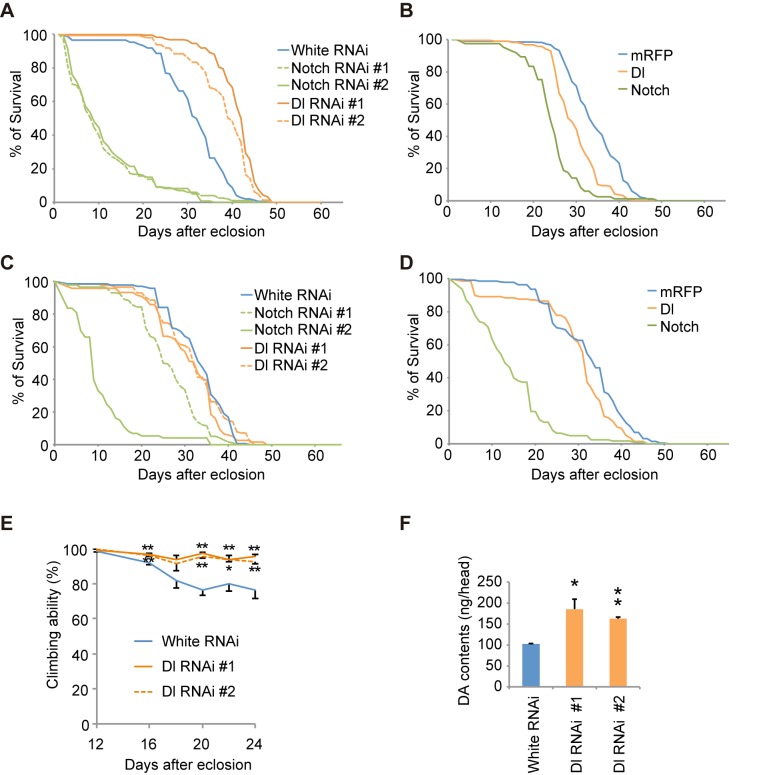
Notch signaling modulates the function of dopaminergic neurons.(A) Inhibition of Dl and Notch in the dopaminergic neurons during adulthood shortens and extends the lifespan, respectively, in Drosophila. p < 0.001 vs. control White RNAi, as determined by the log-rank test (n = 121–203). Flies harboring the indicated UAS-shRNAs were crossed with flies carrying tub-GAL80ts, TH-GAL4. Male offspring were raised at 18°C until eclosion, and the transgenes were expressed at 29°C during adulthood. (B) Ectopic expression of Dl and Notch in dopaminergic neurons during adulthood shortens the lifespan. p < 0.001 vs. mRFP, as determined by the log-rank test (n = 85–222). UAS-transgenes were expressed as in (A). (C) Inhibition of Dl in neurons other than dopaminergic neurons does not affect the lifespan, whereas Notch inhibition shortens the lifespan (p < 0.001, Notch RNAi #1 or #2 vs. White RNAi by the log-rank test. n = 78–178). Flies harboring the indicated UAS-shRNAs were crossed with flies carrying tub-GAL80ts, TH-GAL80, and elav-GAL4. Male offspring were raised at 18°C until eclosion, and the transgenes were expressed at 29°C during adulthood. (D) Ectopic expression of Dl in neurons other than dopaminergic neurons does not affect the lifespan, whereas ectopic Notch expression shortens the lifespan (p < 0.001 vs. mRFP by the log-rank test. n = 141–250). UAS-transgenes were expressed as in (C). (E) Age-dependent reduction of motor activity is improved by Dl inhibition. Flies were raised as in (A). (** p < 0.01, * p < 0.05 vs. White RNAi by one-way ANOVA). The data represent the mean ± SE from 2–6 trials. (F) Brain dopamine (DA) contents were increased by Dl inhibition (** p < 0.01, * p < 0.05 vs. White RNAi by one-way ANOVA. n = 3). Flies were raised as in (A), and adult male flies at 24 days of age were served.